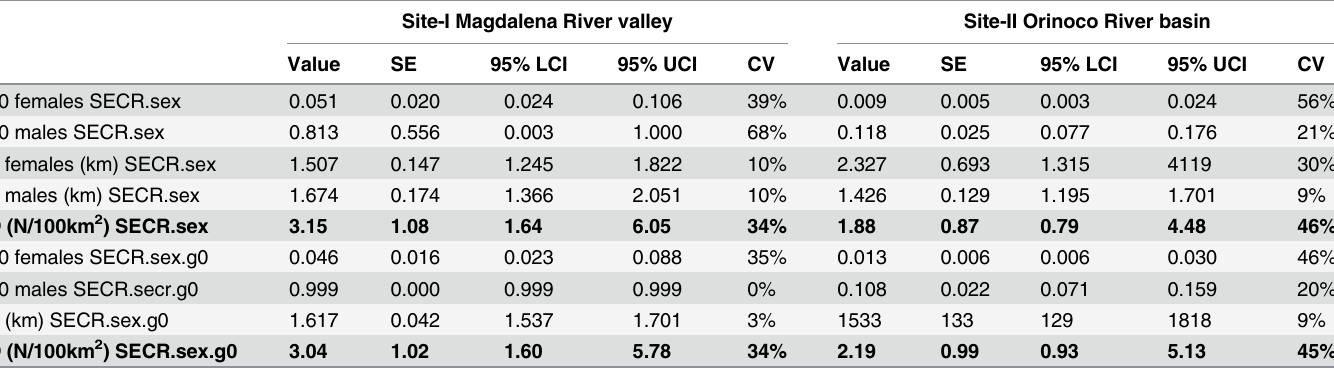
Table 3. Density and parameters estimated by the two best Spatially Explicit Capture Recapture (SECR) models, i.e. SECR.sex and SECR.sex.g0, at Site-I and Site-II.